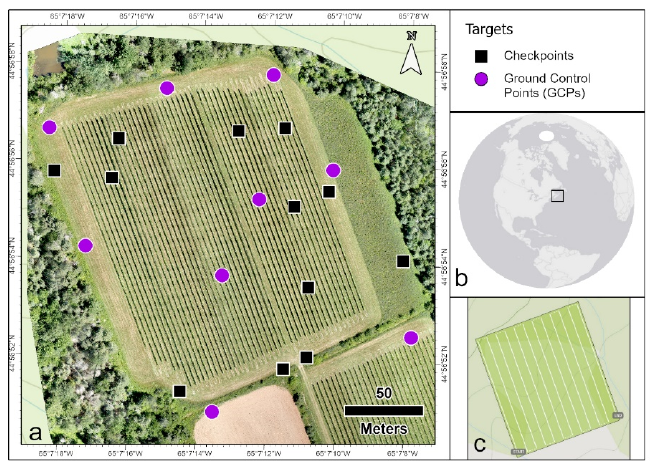
Figure 2. Aerial map ( a ) of study area near Middleton, Nova Scotia, Canada, ( b ) with distribution of 21 targets: 12 checkpoints as purple circles and nine Ground Control Points (GCPs) as black squares. Flights were flown in a grid pattern ( c ) from 70 m elevation.